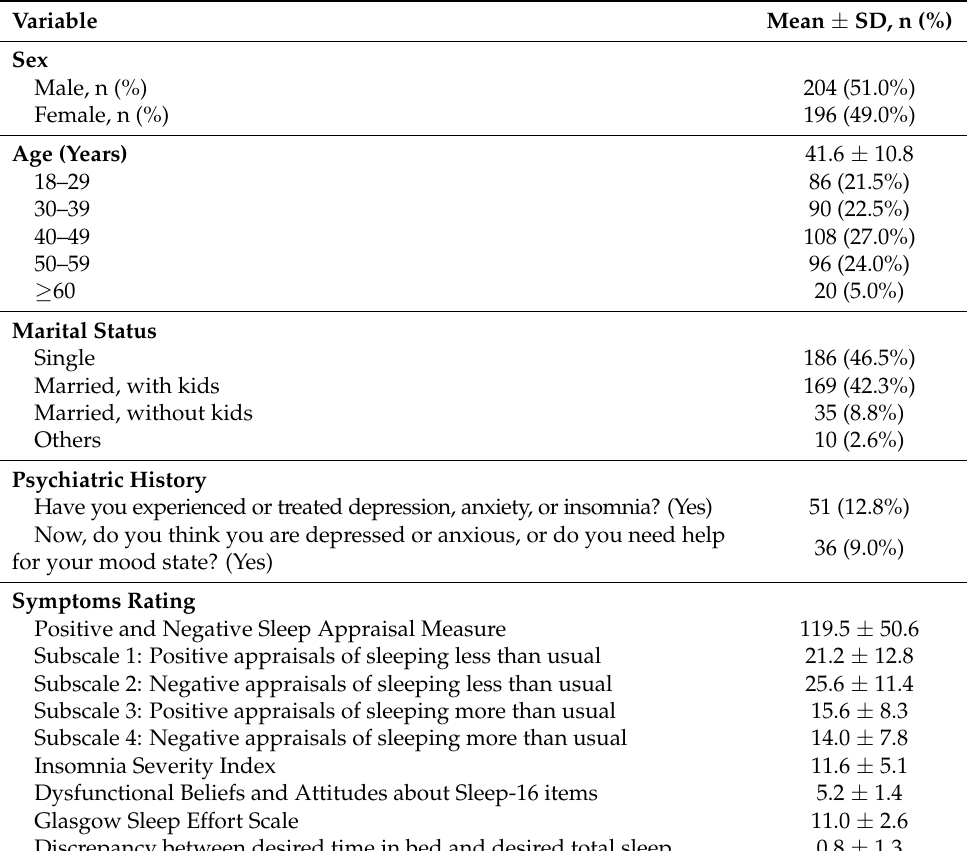
Table 1. Clinical characteristics of the study participants (N =